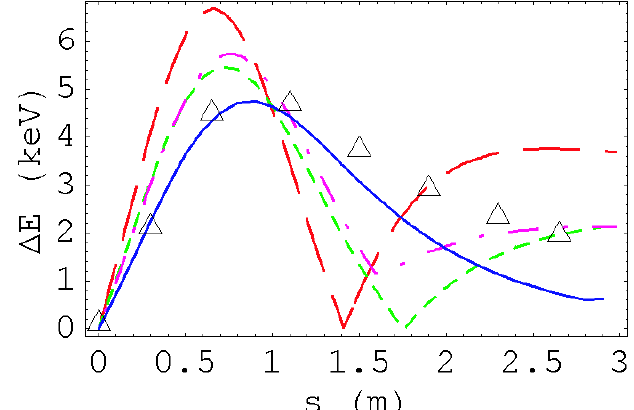
simulation.FIG. 1. (Color) Example of Figs. 10 and 11 of Ref. [6]. The (cid:3) e (cid:4) ^ r 2 = (cid:1) 2 (cid:5) 2 (cid:2) with (cid:5) (cid:3) 0 : 1 and initial density modulation is ^ a FIG. 3. (Color) Comparison of four different analytical ap- 1 d q (cid:3) 1 . The solid curve (blue) is at ^ z (cid:3) 0 , and the dashed curve proaches developed in this paper with PARMELA simulation. (red) is at ^ z (cid:3) 10 . Notations have the same meaning as in The long-dashed curve (red) is the 1D coasting-beam approach, is Ref. [6] and are defined in the text. The ^ E the dashed curve (green) is the coasting beam with radial z dependence approach, the dash-dotted curve (purple) is the 1D bunched-beam approach, the solid curve (blue) is the bunched- beam approach with radial dependence, and the ‘‘ 4 ’’ (black) is the PARMELA